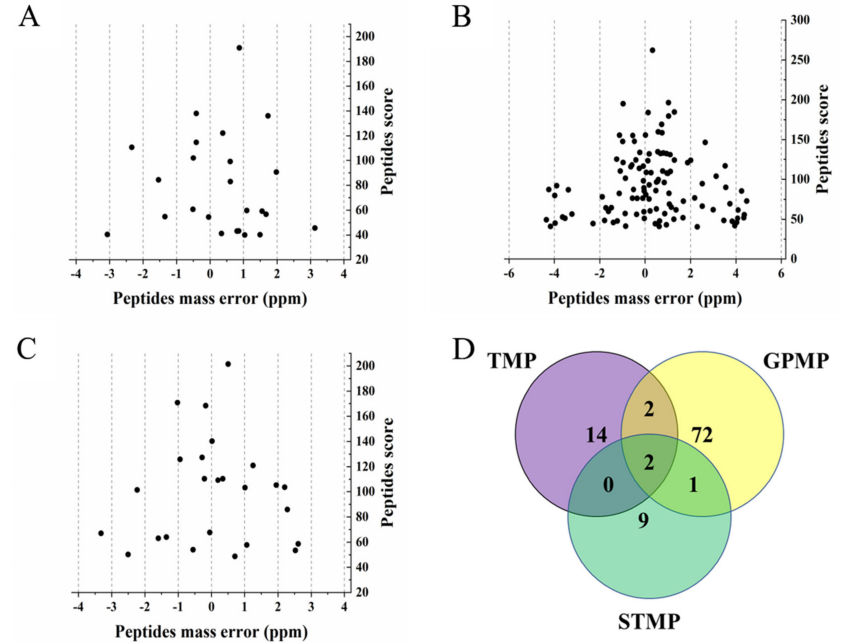
Figure 4. Mass error distribution of identified N-glycopeptides (( A ) TMP, ( B ) GPMP and ( C ) STMP) and overlapping Venn diagram of identified N-glycoproteins ( D